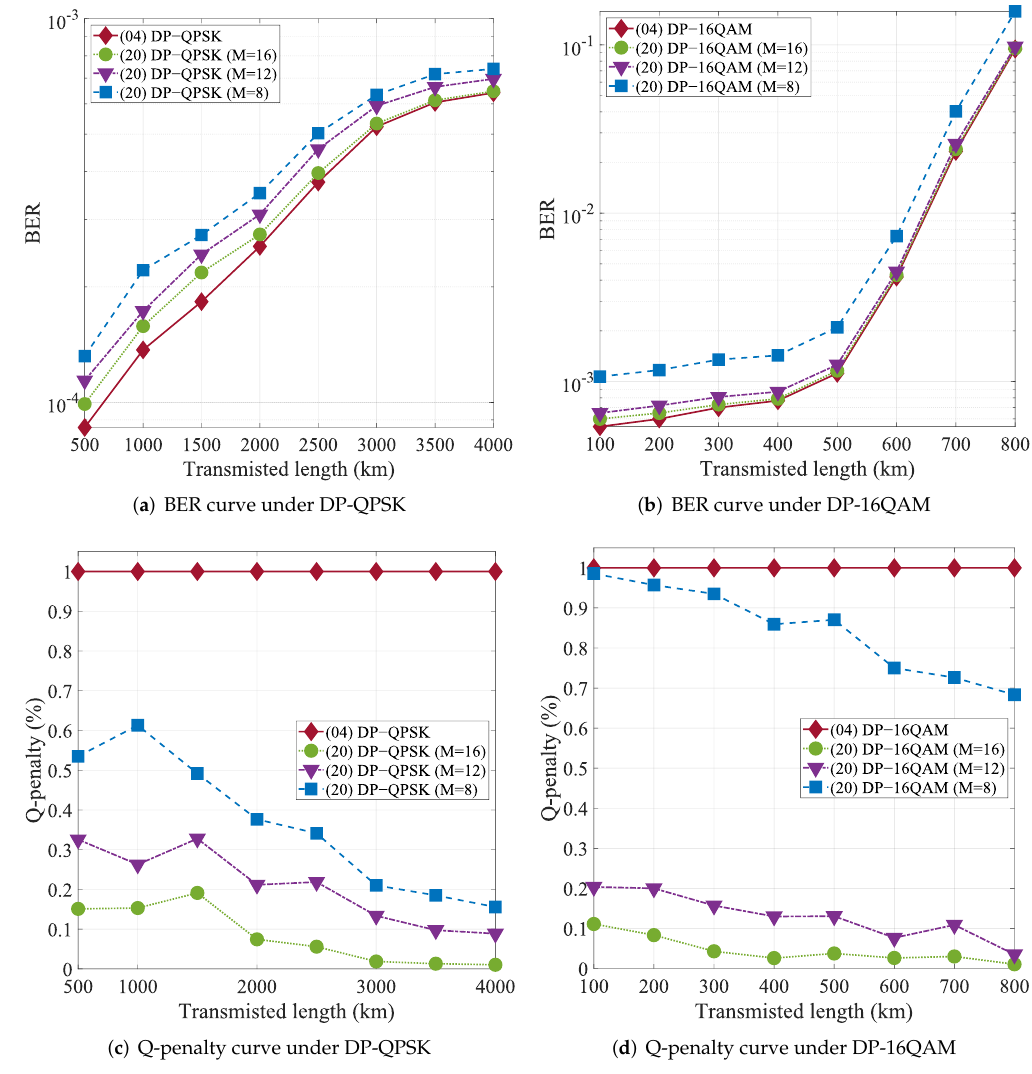
Figure 6. The BER and Q-penalty performance of the DP-QPSK and DP-16QAM data. We compare the filters of the TD-CDE FIR filter and the CQWO-TD-CDE FIR filter under different transmission distances. ( a ) BER curve under the DP-QPSK; the fiber transmission distance is from 500 km to 4000 km, respectively. ( b ) BER curve under the DP-QPSK; the fiber transmission distance is from 100 km to 800 km. ( c ) Q-penalty curve under the DP-QPSK; the fiber transmission distance is from 500 km to 4000 km. ( d ) Q-penalty curve under the DP-16QAM; the fiber transmission distance is from 100 km to 800